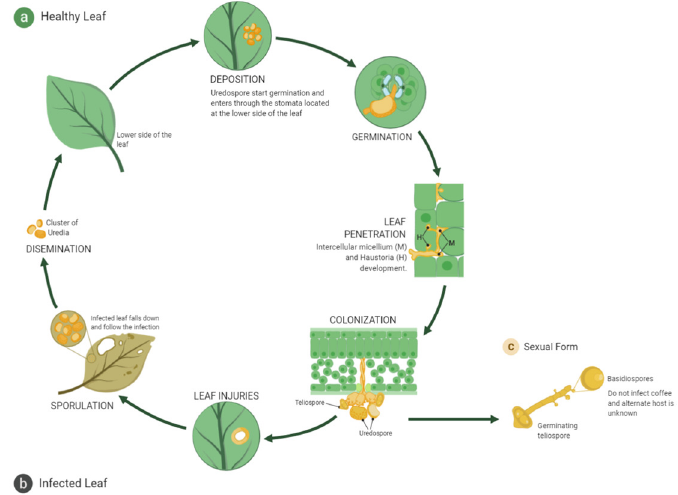
Figure 1. Scheme based on the infectious cycle of the fungus Hemileia vastatrix . Specifically, for organic cultivars (shaded production schemes), the spores finish their infection cycle in 30–60 days, and the dispersion phase begins. As the application of chemicals is limited or prohibited in organic crops, spores remain dormant, waiting for a new host to restart the infectious cycle.